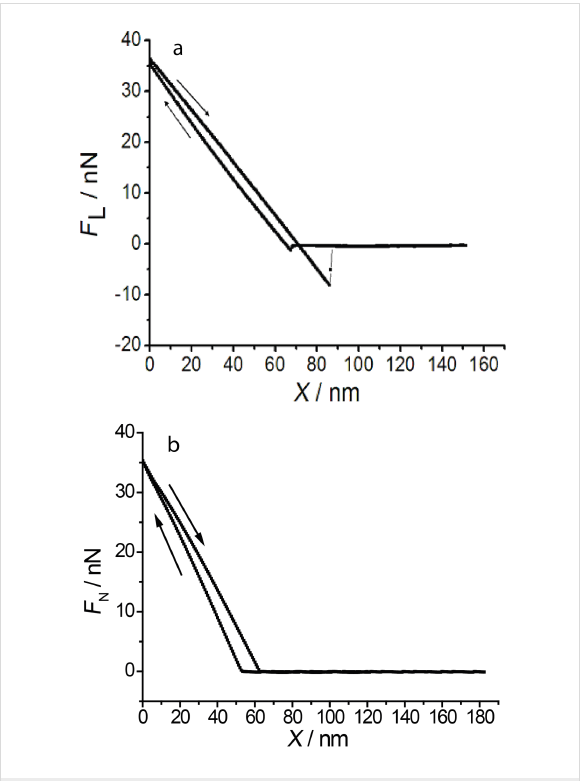
Figure 14: Force–distance curves at potentials of a) 220 mV, b) 150 mV. A large snap-off force due to adhesion is only found for potentials positive of the